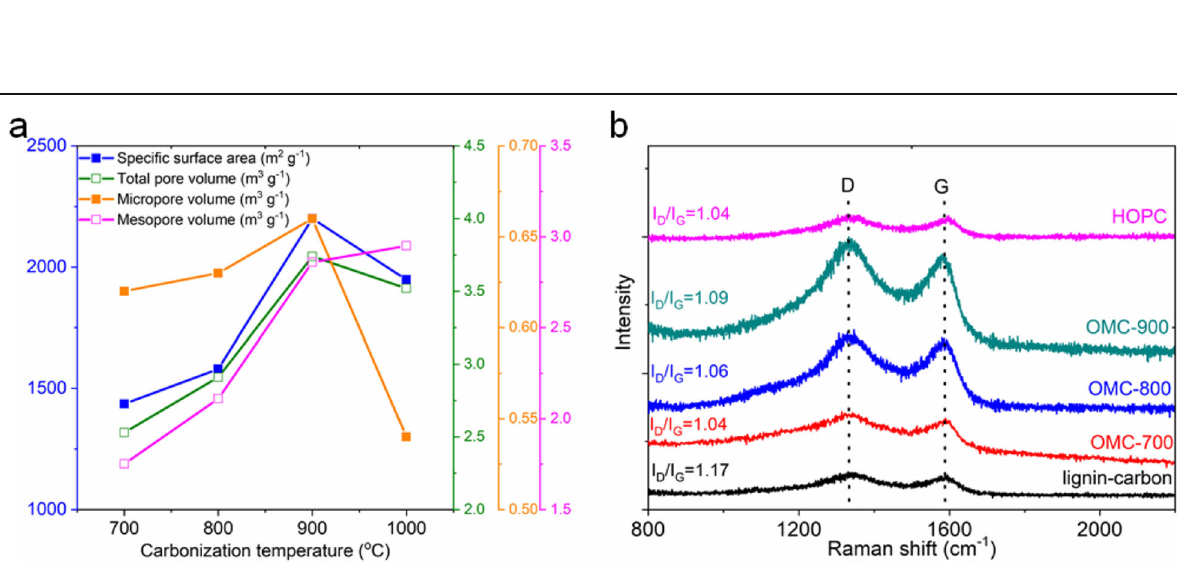
Fig. 3 Characterization of the as-prepared OMC carbon and the HOPC samples. a The specific surface area, total pore volume, micropore volume, and mesopore volume as the function of carbonization temperature. b Raman